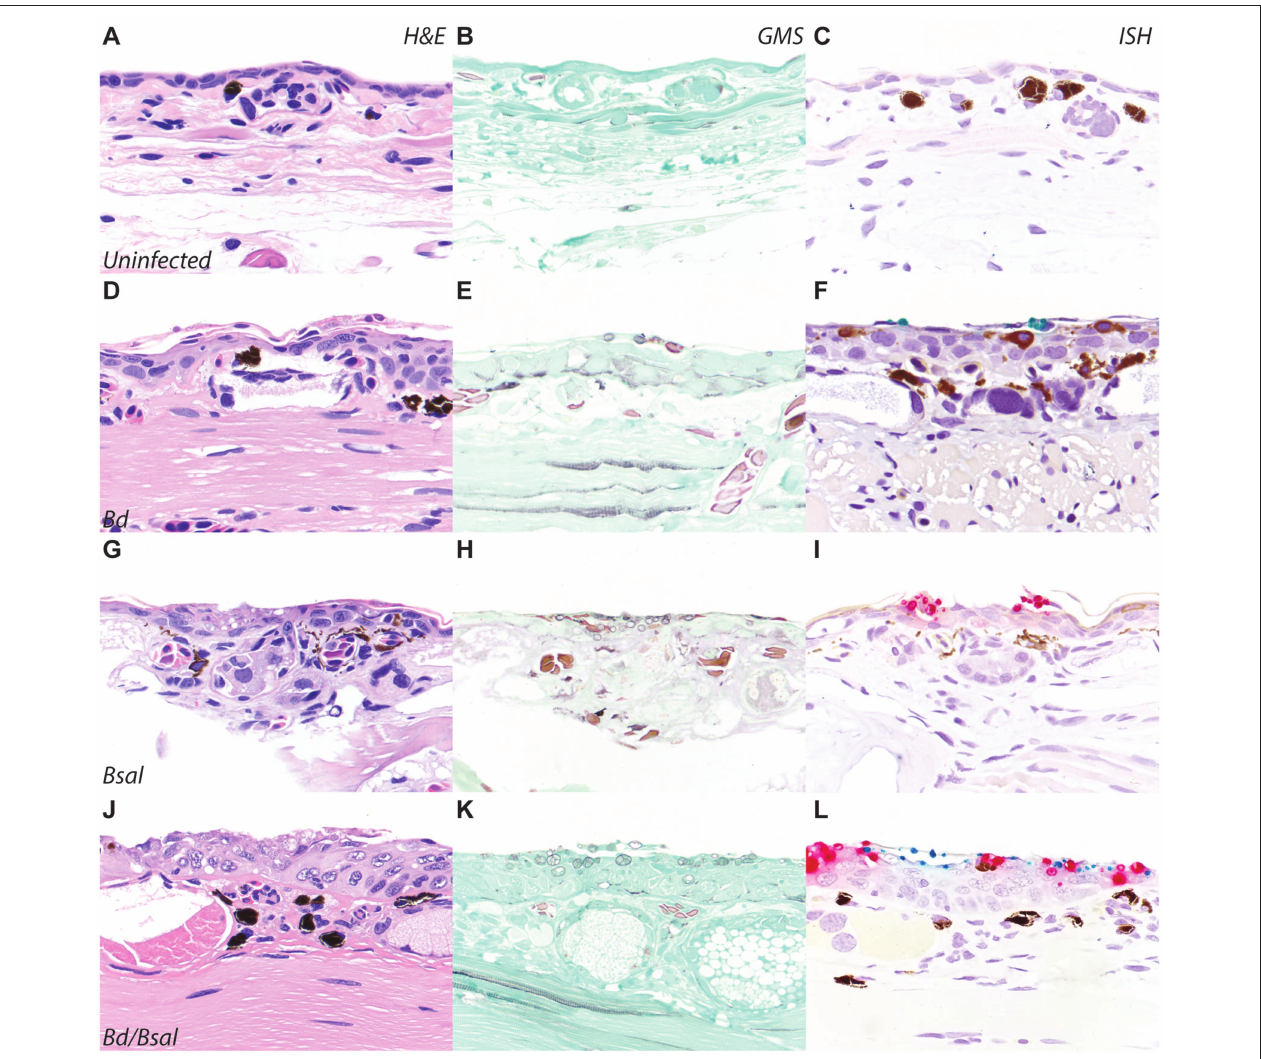
FIGURE 2 | Bd / BSal RNAScope ® ISH of eastern newts ( Notophthalmus viridescens ). Skin sections from uninfected (A–C) , Bd -infected (D–F) , Bsal -infected (G–I) , or Bd / Bsal infected (J–L) are stained with hematoxylin and eosin (A,D,G,J) , Gomori methenamine silver to highlight fungal organisms (B,E,H,K) , or Bd / Bsal ISH (C,F,I,L) . Bd probe binding is visualized by green staining (F,L) and Bsal probe binding is visualized by red staining (I,L) . In all cases of chytridiomycosis, the presence of fungal organisms is accompanied by epidermal hyperplasia and hyperkeratosis. All images are at 200x magnification.